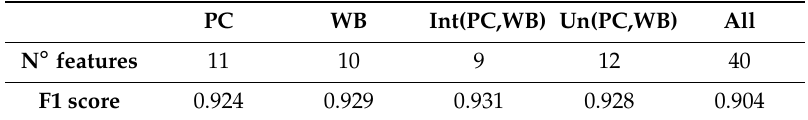
Table 4. Comparison of di ff erent feature selection methods for terrain classification.